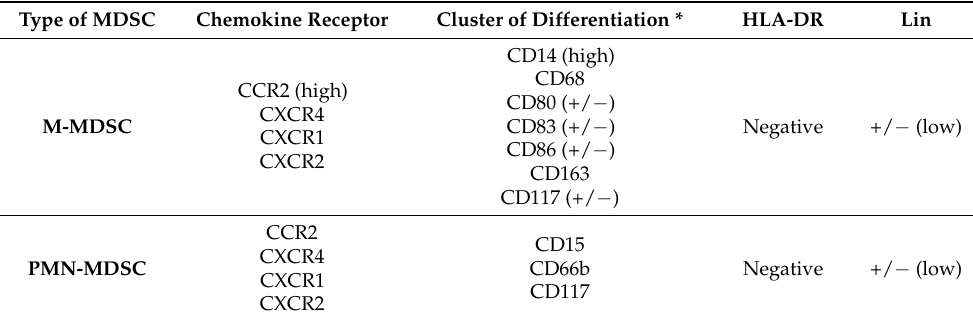
Table 2. Differential expression markers in the clinical identification of MDSC